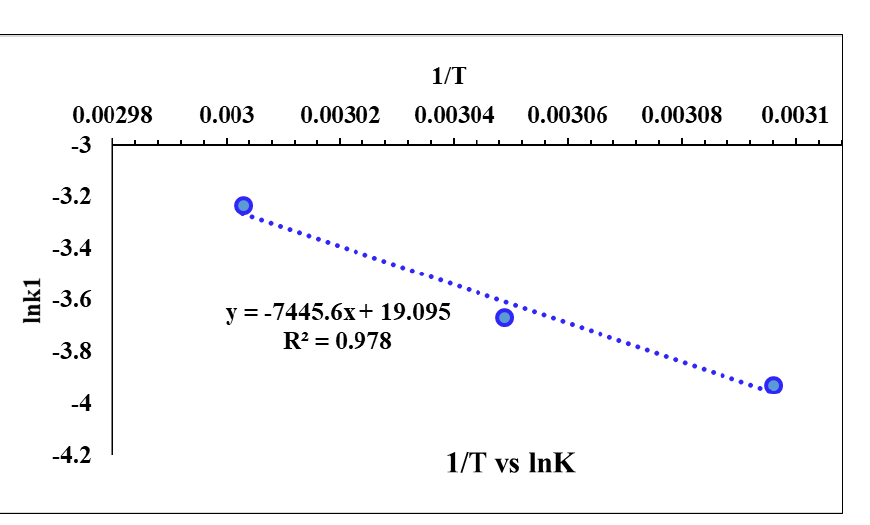
Figure 20. 1/T vs. lnk 1 plot to determine the activation energy (Ea) and frequency factor (A f ) for the Transesterification process.